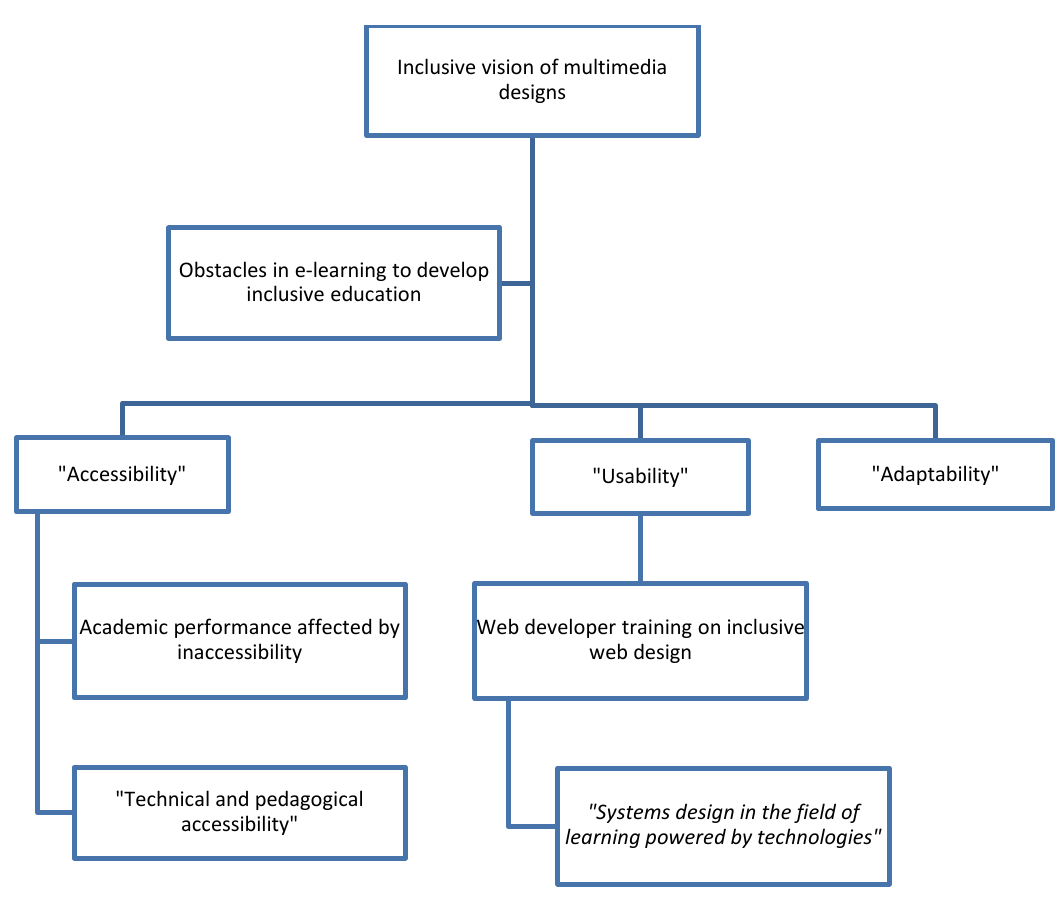
Figure 8 . Inclusive vision of multimedia design. This mind map illustrates the property and its dimensions. The dimensions give off codes, with some of them framed in quotation marks and italics. This is because they are "in vivo" codes and/or quotations from some of the articles studied, while the others are codes created by the